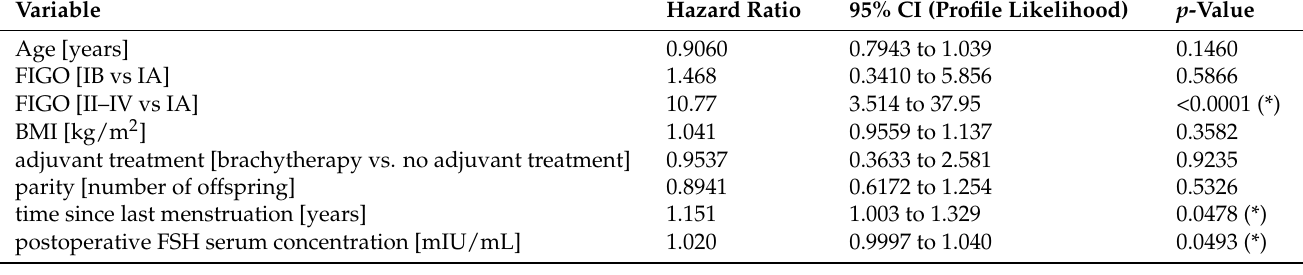
Table 3. Hazard ratios and p -values for the Cox proportional hazard regression model. An asterisk symbol (*) was used to denote the variables identified as statistically significant ( p < α). BMI: body mass index; FIGO: the International Federation of Gynecology and Obstetrics; FSH: follicle-stimulating hormone.